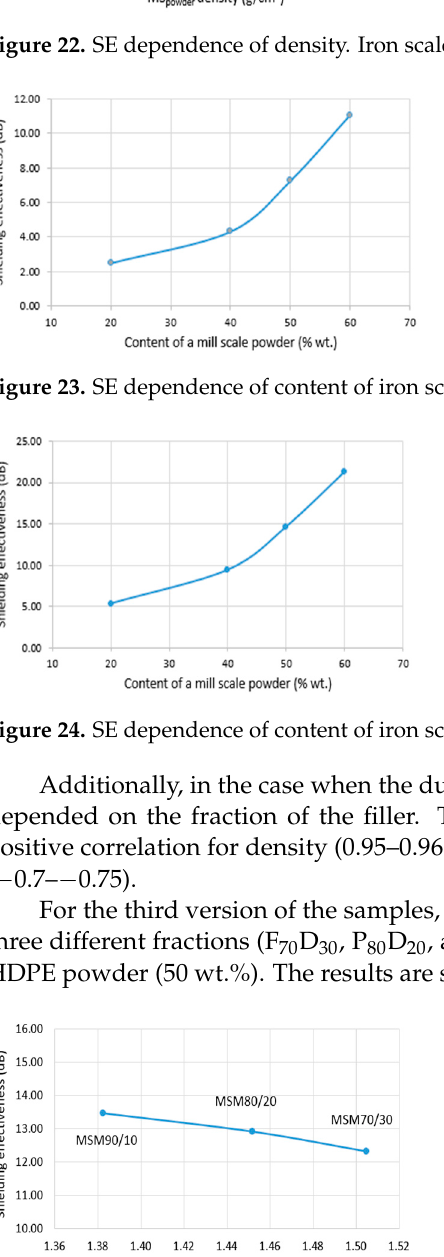
Figure 26. SE dependence of content of iron scale mix of flakes and powder. Frequency—10 GHz. Figure 27. SE dependence of content of iron scale mix of flakes and powder. Frequency—23 GHz. The obtained results were comparable to the SE values obtained for the scale in the form of flakes. However, according to the results of the measurements of mechanical